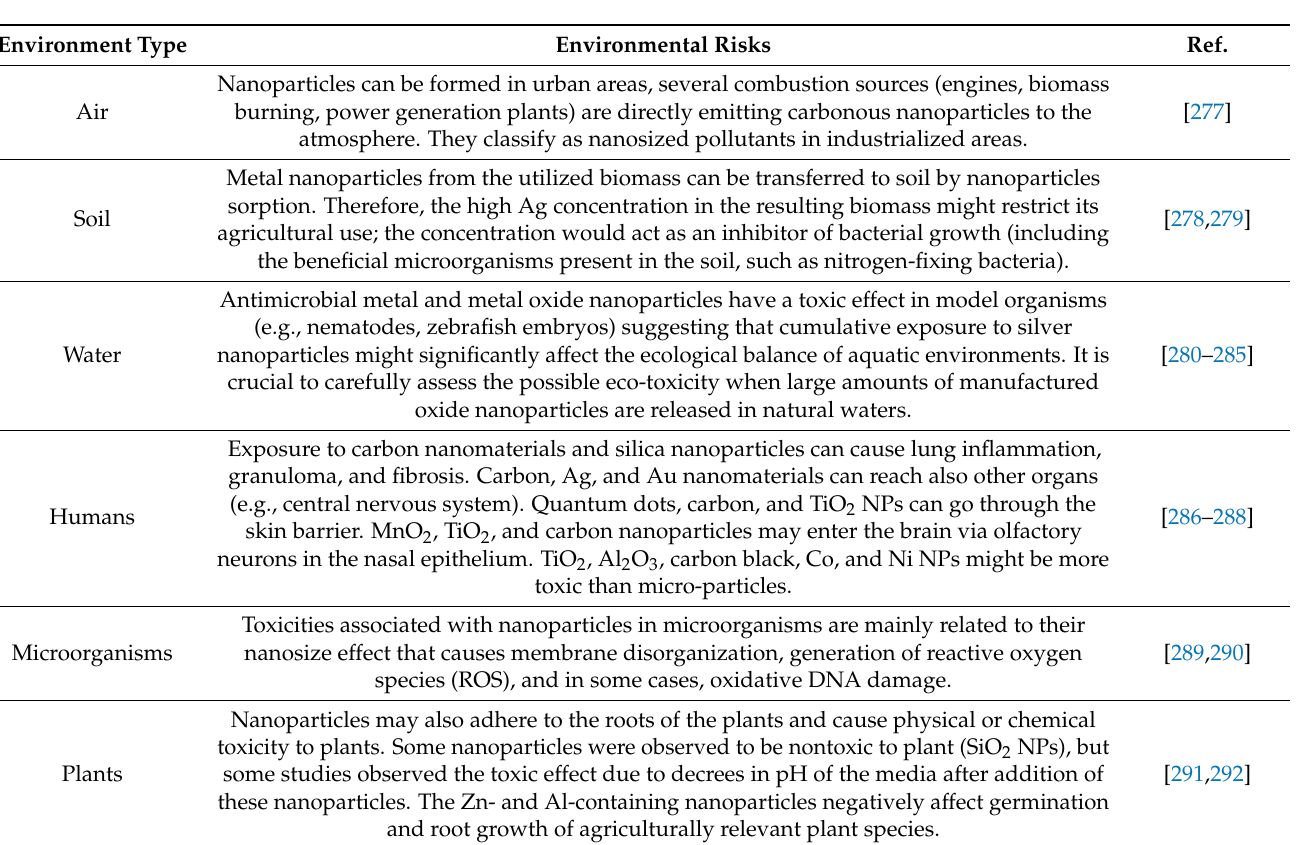
Table 5. Environmental risks of